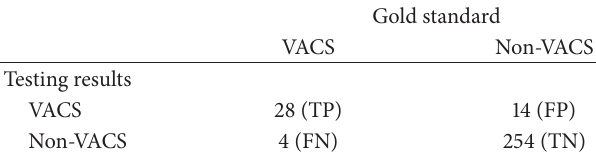
Table 5: Evaluation about